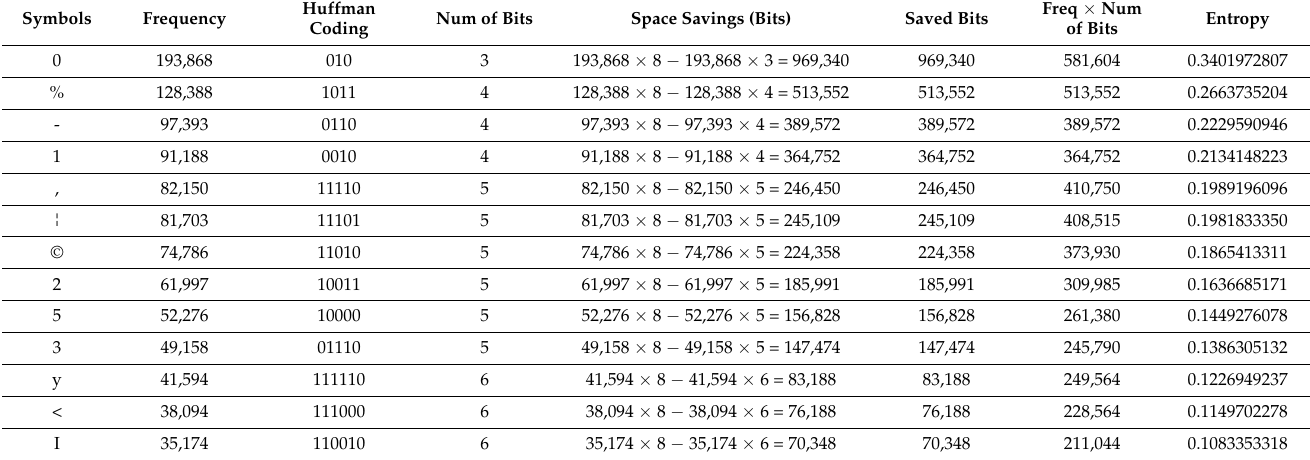
Table A1. Fixed character encoding and decoding map used in this study.